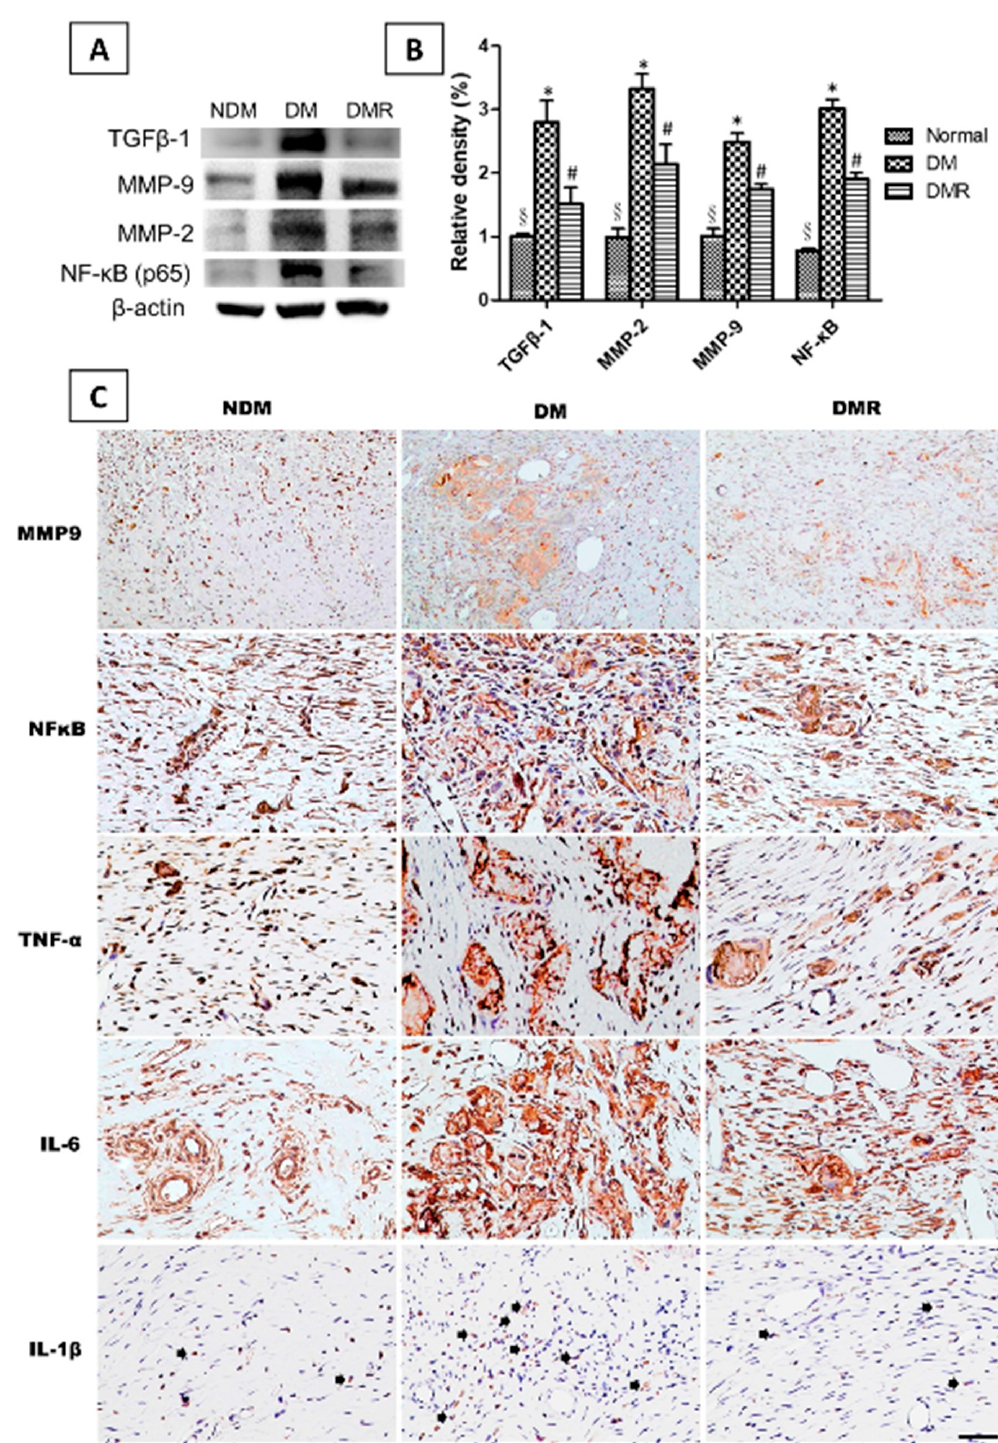
Figure 7. The expression of NF- κ B, MMP-2, MMP-9 and TGF β -1 was analyzed by Western blotting ( A , B ). Distributions of MMP-9, NF- κ B, TNF- α , IL-6 and IL-1 β (arrow) expressions based on immunohistochemistry results ( C ). Brown represents positive staining for MMP-9 in NDM, DM and DMR cytoplasms (magnification, × 100). * p < 0.05 DM compared with the NDM group, § p < 0.05 DMR compared with the NDM group, # p < 0.05 DMR compared with the DM